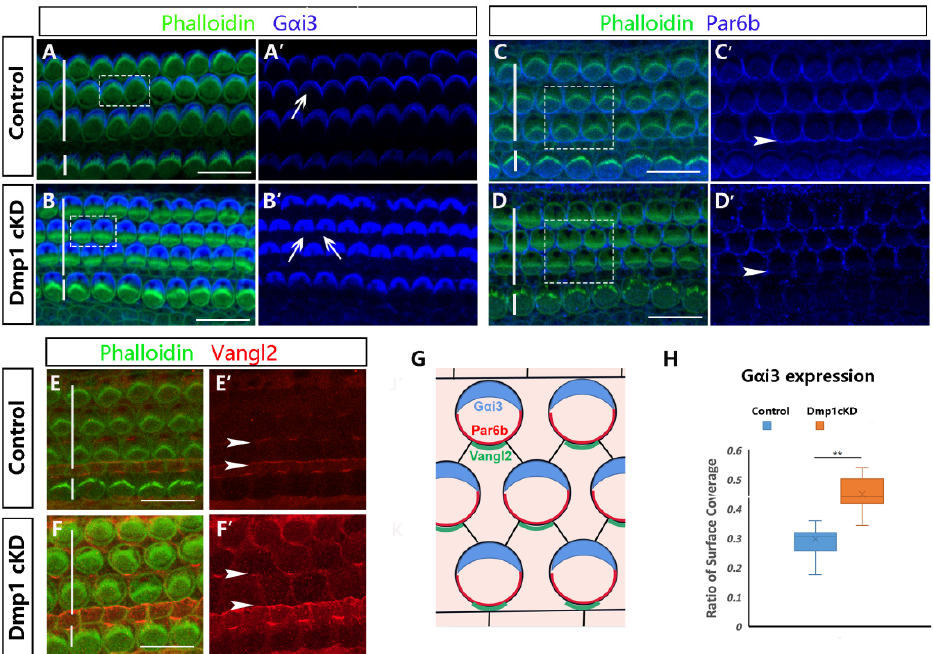
Figure 4. Dmp1 inactivation affected the cell-intrinsic polarity of HCs. ( A – D ): G α i3 and Par6b localization in the control and Dmp1 cKD OC at P1, G α i3 and Par6b staining was singly showed in ( A (cid:48) – D (cid:48) ). ( G ): Cartoon depicting asymmetric localization of G α i3, Par6b and Vangl2 in the organ of Corti. It was obvious that G α i3 formed a crescent-shaped region lateral to the stereocilia bundle on the apical surface of HCs and the region of G α i3 protein expression was expanded significantly in mutant mice (white arrows in B (cid:48) ). Par6b is expressed on the medial apical surface and the localization of Par6b in the first row of hair cells was subtly altered and absent in mutant mice (white arrows in D (cid:48) ). ( H ): Box plot of the quantification of G α i3 expression expansion (the ratio of G α i3 region position to the total epidermal plate area), counting 125 OHCs from 3 WT mice and 121 OHCs from 3 Dmp1 cKD mice. ( E , F ): Localization of the core PCP components Vangl2 in control and Dmp1 cKD cochlea, Vangl2 staining was singly showed in ( E (cid:48) , F (cid:48) ). There was largely intact asymmetric localization of Vangl2 along the medial HC junctions.Statistical significance was calculated using a t ‐ test. * p < 0.05, ** p < 0.01. Scale bars: 10 μ m.